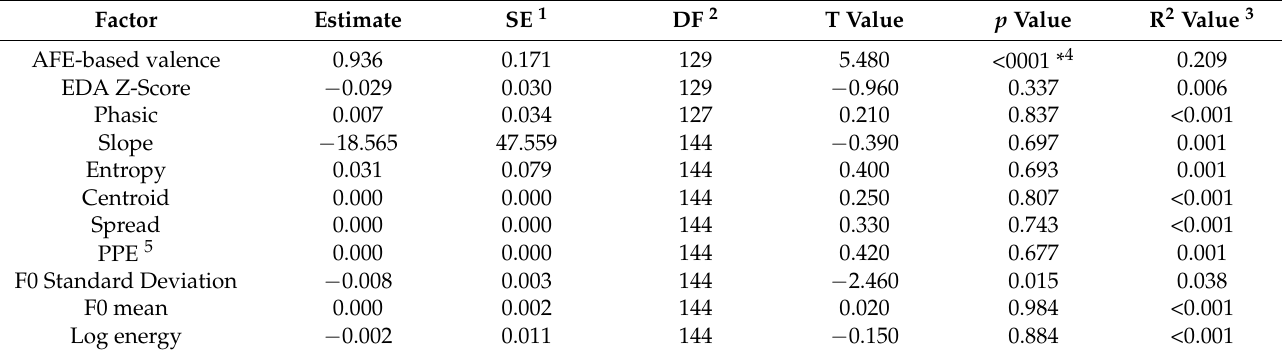
Table 8. Regression results of STEE